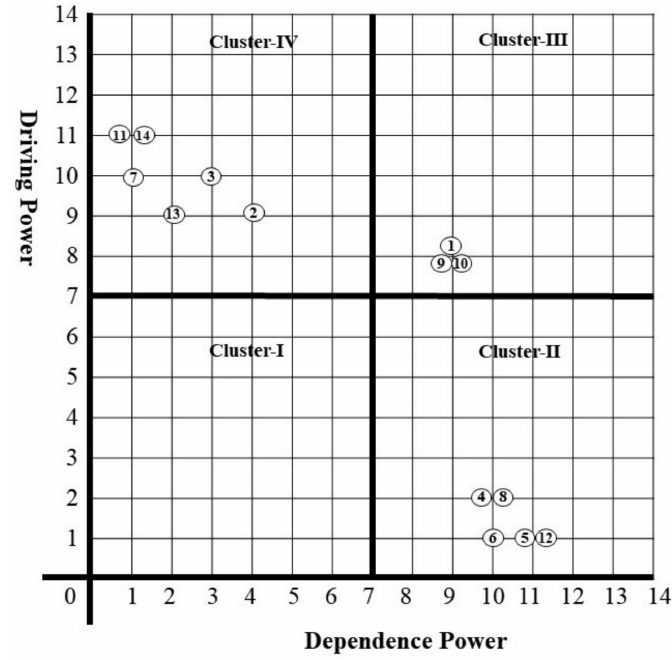
Figure 2. Result of the MICMAC